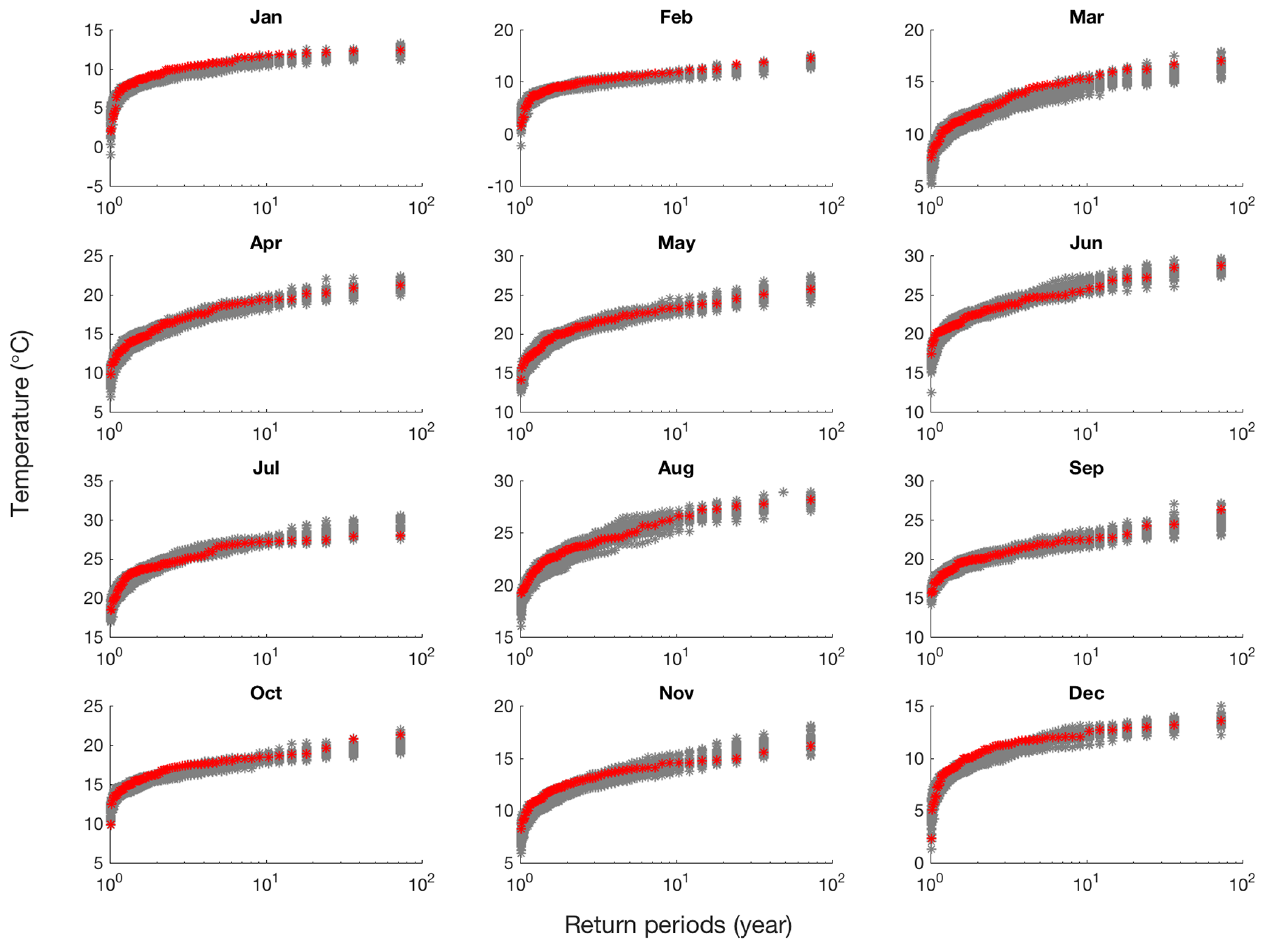
Figure 7. Comparison between the return periods of monthly extremes of the observed and simulated temperature values: Uccle is in red and the ensemble of 50 time series simulated using the C-vine copula V T